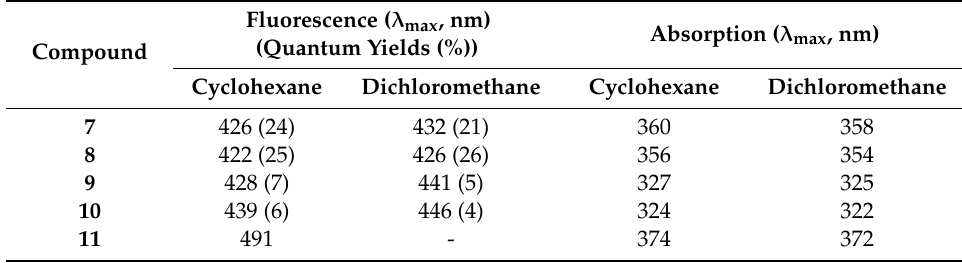
Table 2. λ max (nm) of absorption spectra, λ max (nm) of emission spectra, and relative quantum yields (%) of compounds 7 – 11